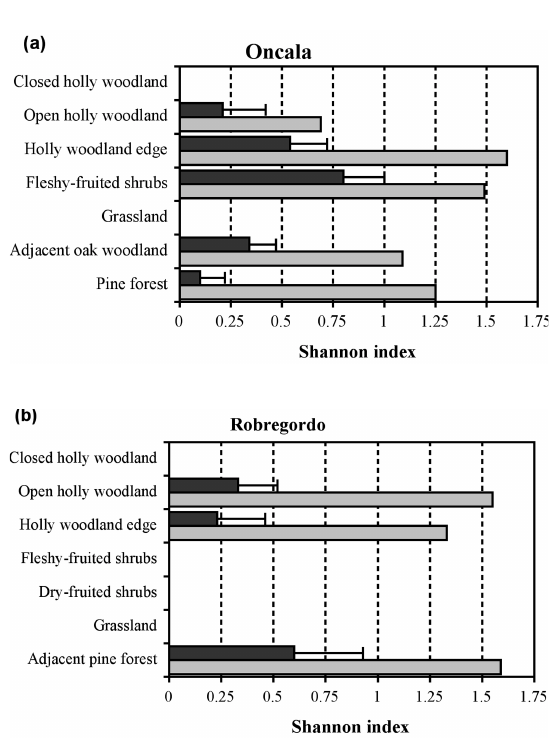
Fig. 2. Shannon diversity indices for seedlings from previous years (PYS) per sampled area in both locations. Black bars, mean + SE diversity index at quadrat scale. Grey bars, total habitat di- versity index. If no bars are present, diversity is equal to zero, except in grassland of Robregordo, where no seedlings are